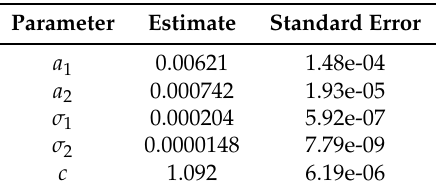
Table 1. Parameters of the Calibrated Mortality Model—Australian Population Males Aged 50 to 100 for years 1960 to 2009.